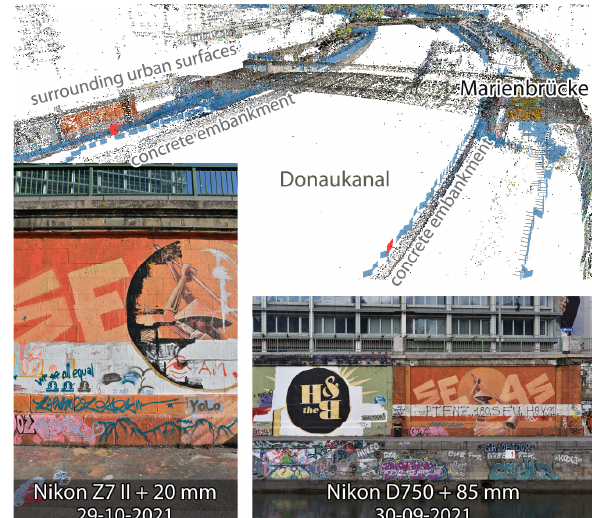
Figure 3 . The location of all photographs acquired around the Marienbrücke (Marien Bridge) is indicated in semi-transparent blue. The location of the depicted Nikon Z7 II and Nikon D750 photographs is shown via a red rectangle. The scene's structure is represented by a cleaned cloud of 3D tie